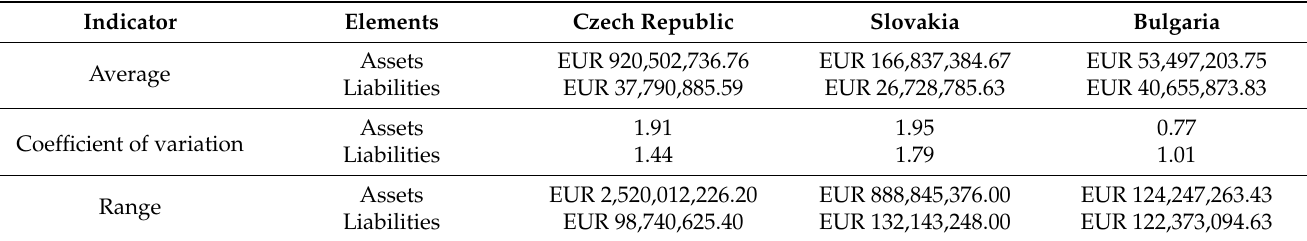
Table 2. Descriptive statistics for each